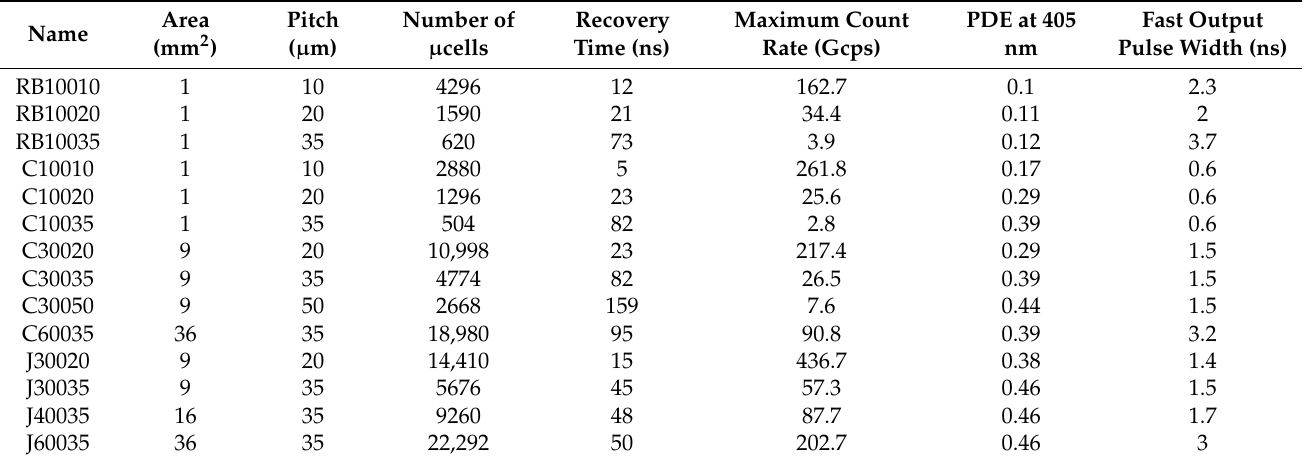
Table 1. Key parameters for the three series of commercially available SiPMs manufactured by onsemi